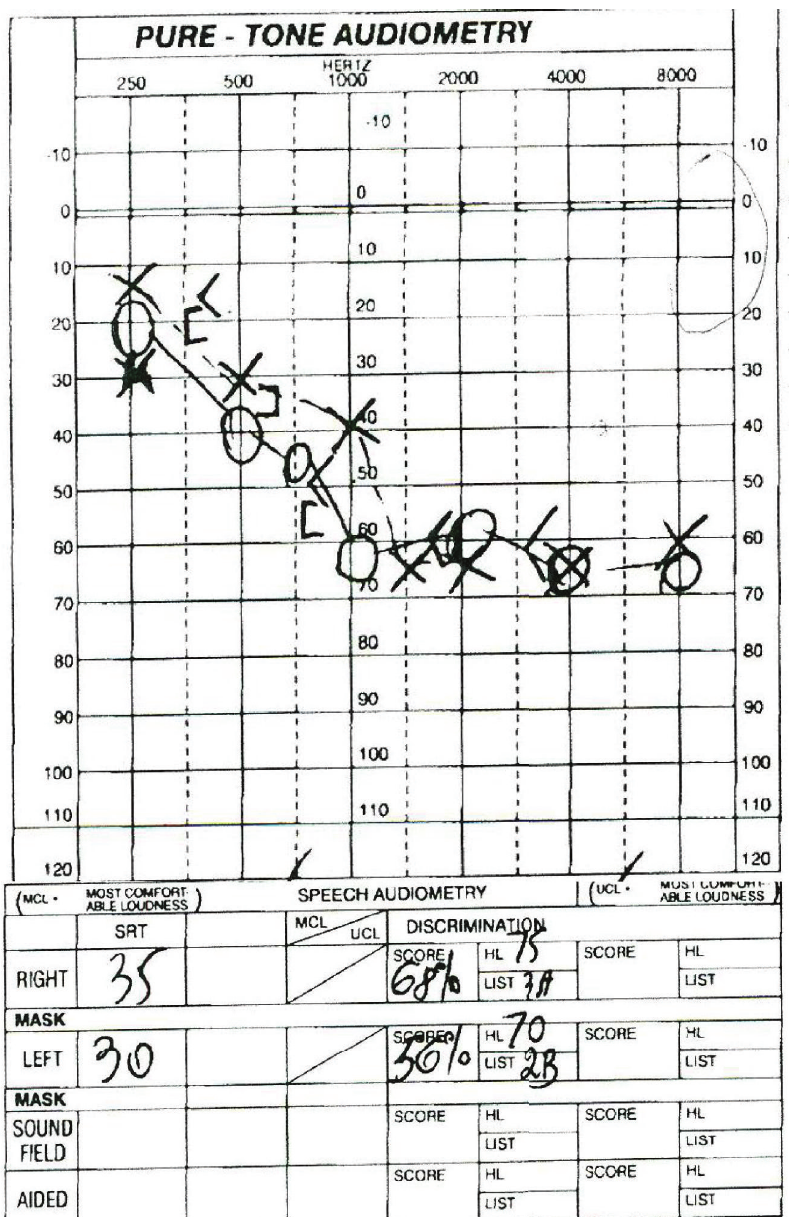
Figure 1: Audiometry graph one month after